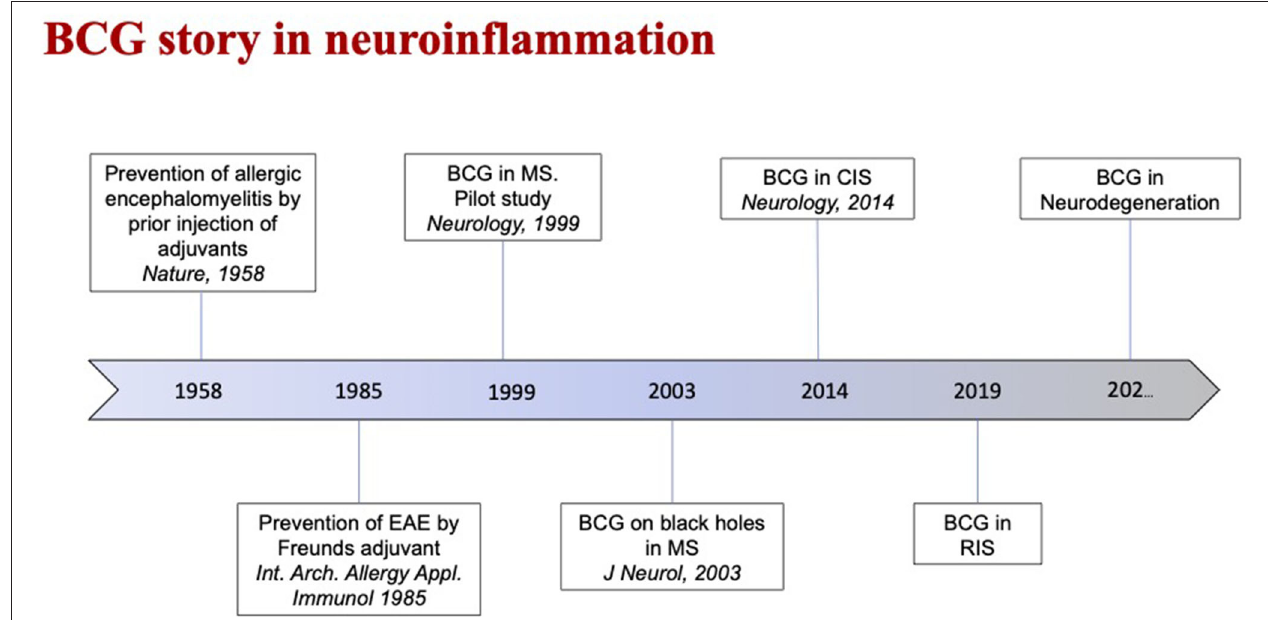
FIGURE 2 | This time-line highlights the evolution of the role of Bacille Calmette-Guérin (BCG) vaccine in neuroinflammatory diseases as Multiple Sclerosis (MS).